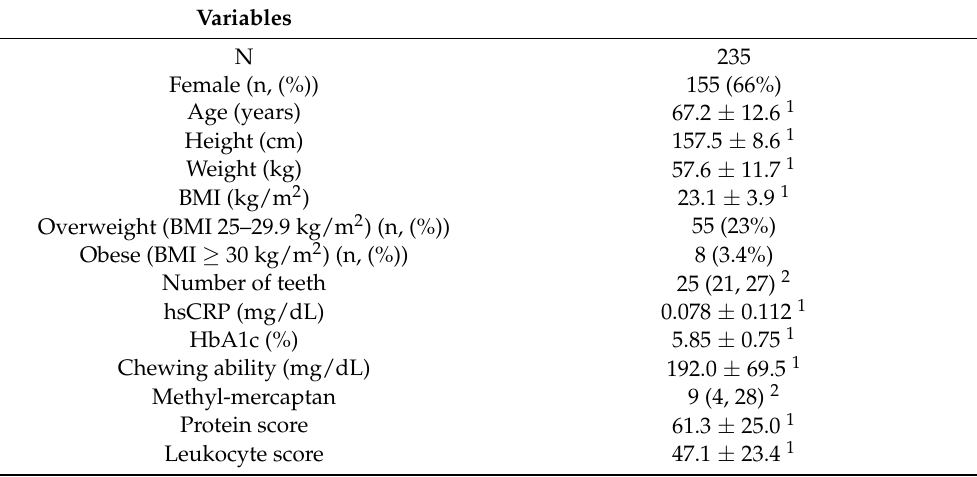
Table 1. Subject characteristics.